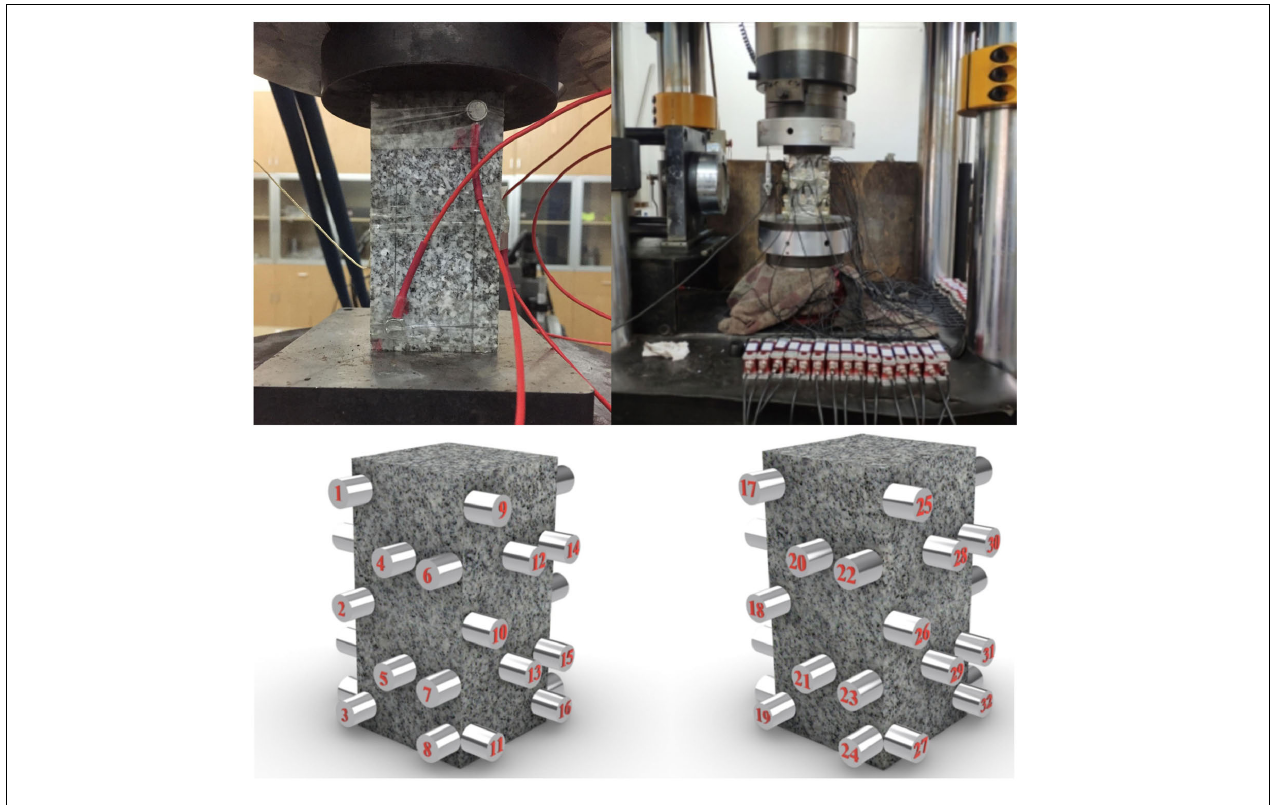
FIGURE 1 | Experimental instruments and Installation and distribution diagram of AE sensor (100 mm × 100 mm × 200 mm sample). (Top Left) 50 mm × 50 mm × 100 mm sample under uniaxial compression experimental equipment. (Top Right) 100 mm × 100 mm × 200 mm sample under uniaxial compression experimental. (Bottom) The sensors arranged on two parallel sides are misaligned to reduce duplication of arrival time data for AE source